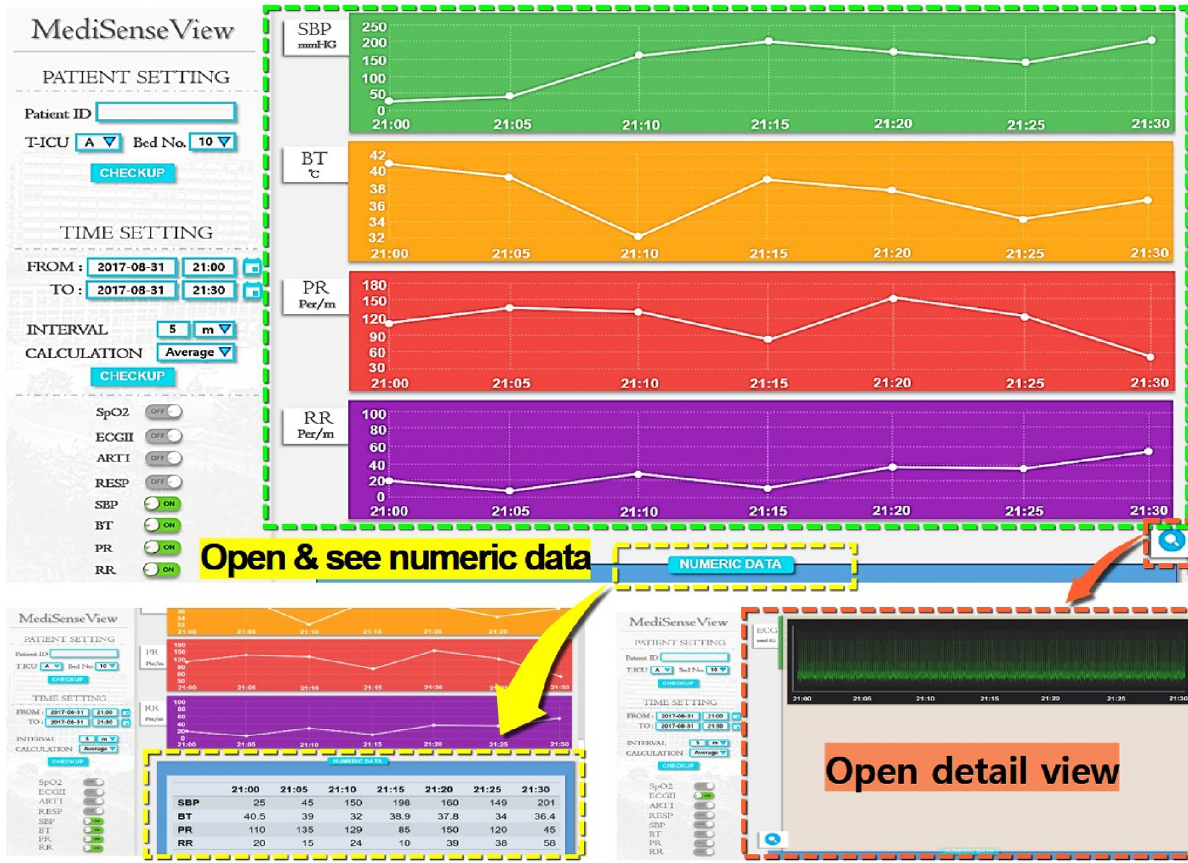
Fig 9. The second version of MediSenseView . This version is designed based on the feedback from the first design meeting with the trauma center panel. We present how the screen expands as different buttons are pressed.